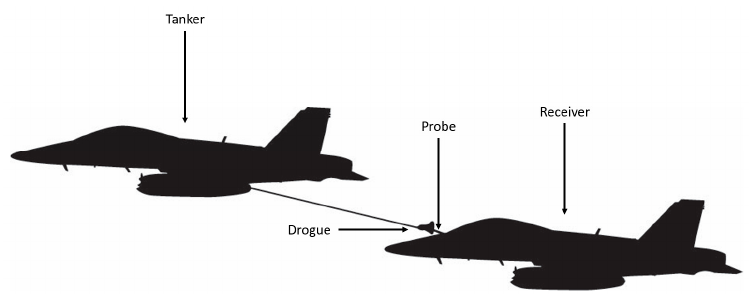
Figure 1. Example of probe and drogue refueling.